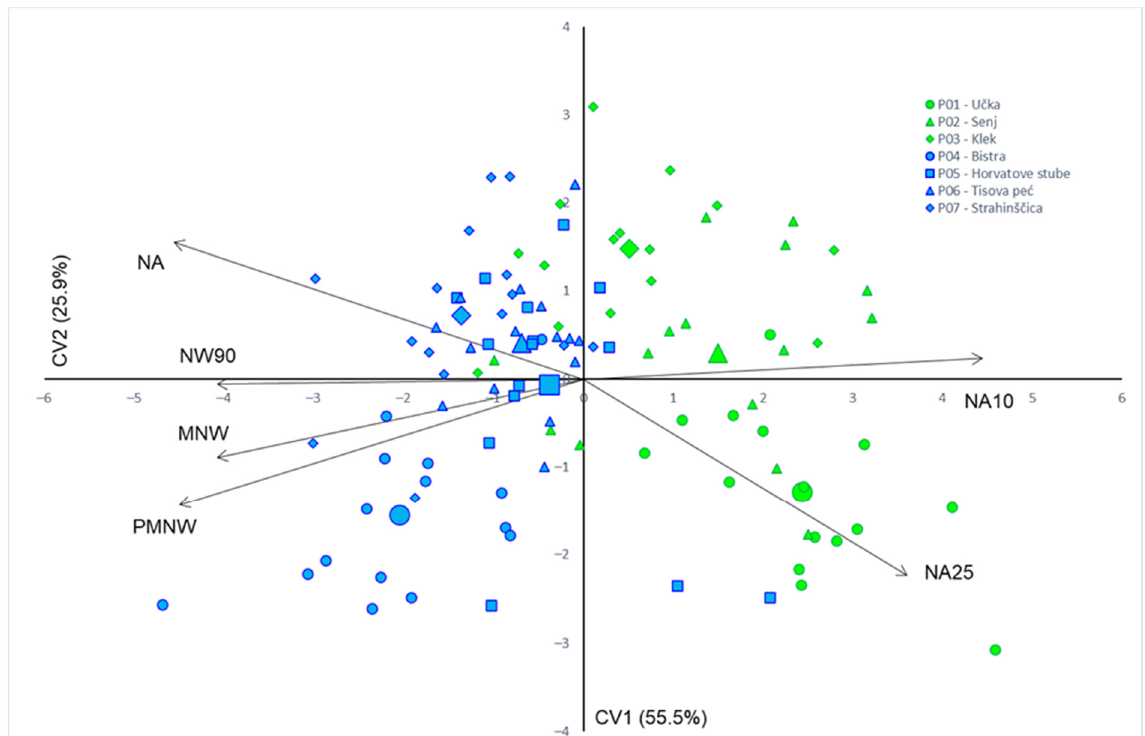
Figure 3. Analysis of discrimination for seven Taxus baccata populations based on six morphological traits that were the most useful for maximum discrimination between studied populations. Each individual tree is indicated by a small sign, while the population barycenters are represented by larger ones. Colour of the signs is related to geographical region: green colour—Dinaric region; blue colour—continental region. Morphometric traits: needle area (NA); maximum needle width (MNW); needle length, measured from base to the widest point of needle (PMNW); needle width at 90% of needle length (NW90); angle enclosed by the main vein and line between needle base and point on the 10% of needle length (NA10); and angle enclosed by the main vein and line between needle base and point on the 25% of needle length